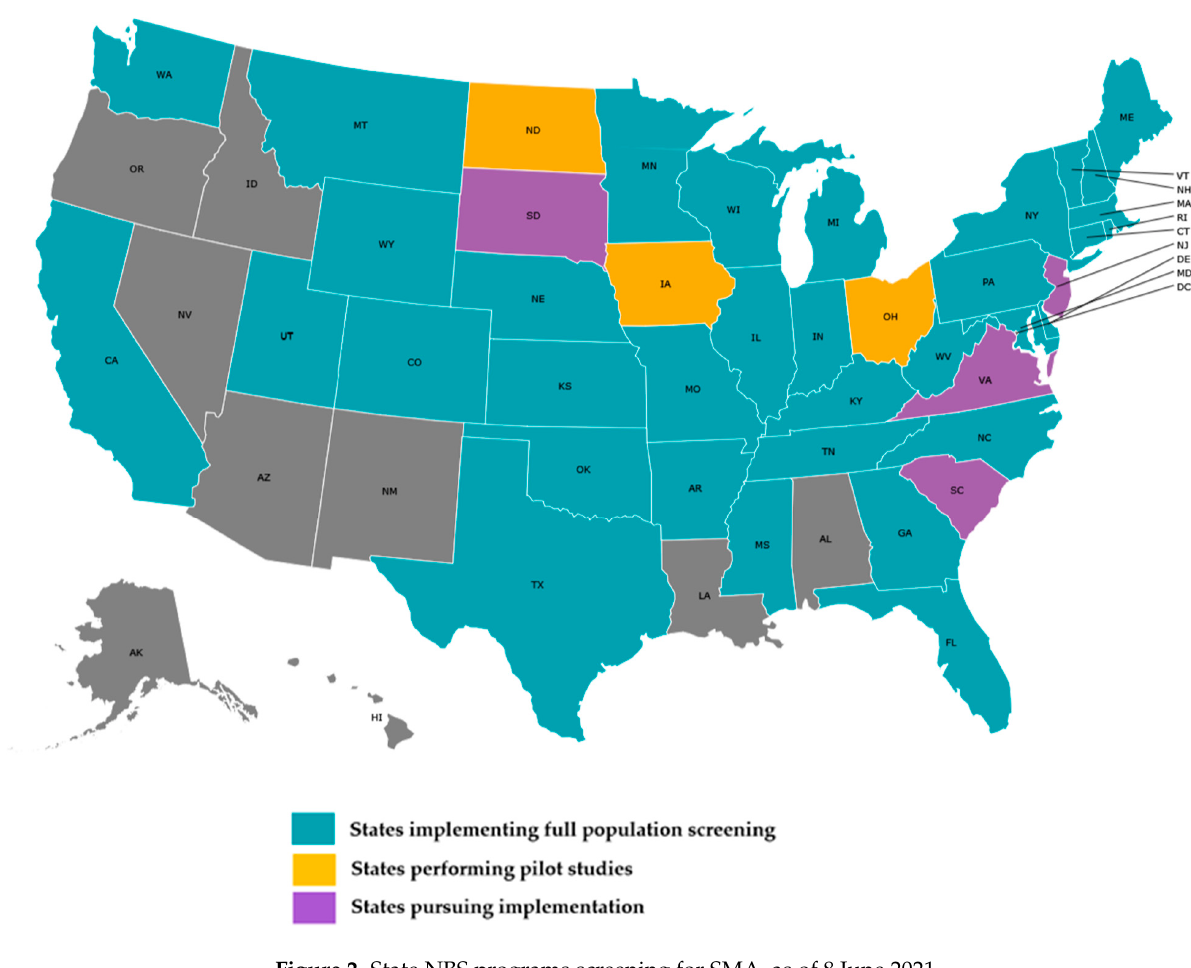
Figure 2. State NBS programs screening for SMA, as of 8 June 2021. Table 3. Time to full implementation of statewide screening for new disorders. Preliminary results from the NewSTEPs New Disorder Readiness Scale, as of 31 August 2019.